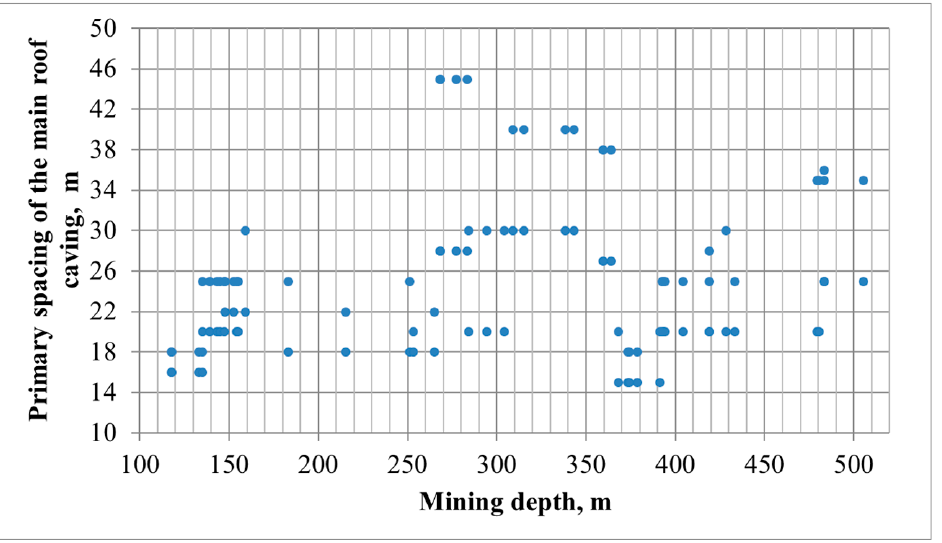
Figure 2. Dispersion of values of the primary spacing of the main roof caving depending on the depth. According to Figure 2, a zone of primary main roof caving is within the range of 15.0–45.0 m. At a depth of 120.0–150.0 m as well as at a depth of 370.0–440.0 m, the primary caving spacing has its minimum values of 15.0–20.0 m. At a depth of 220.0–300.0, the caving spacing has a maximum limit of 35.0–45.0 m; at a depth of 470.0–505.0 m, it is 30.0–35.0 m. The 15.0–35.0 value of caving spacing is observed at all depths of the mine working, being 100.0–500.0 m. The scientific contribution of the research, with numerical modeling and an analysis of the stress–strain state around a stope, is presented in this paper [25]. Thus, based on the aforementioned, the zones of the primary main roof caving were outlined, and the sinusoidal nature of the changes in the caving spacing along with the depth was